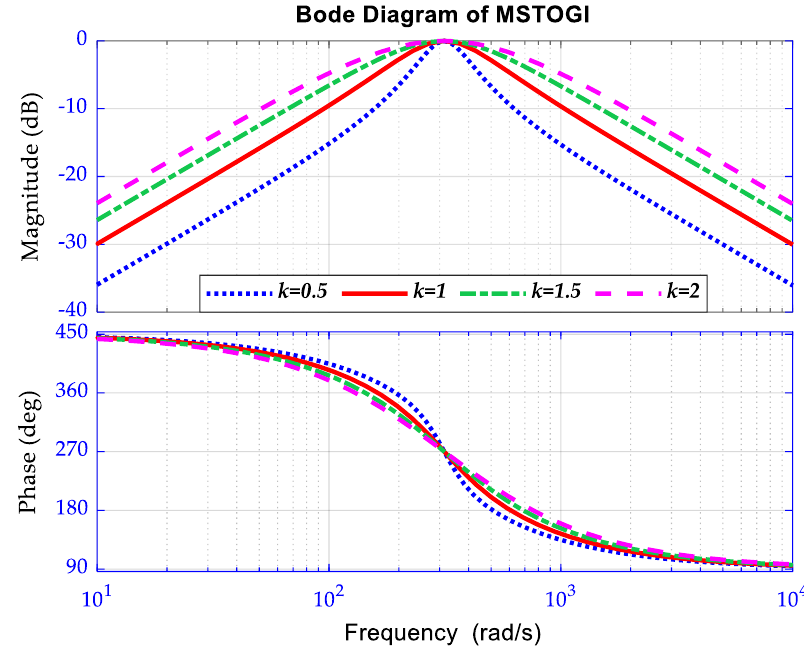
Figure 6. Bode diagrams of Q MSTOGI ( s )